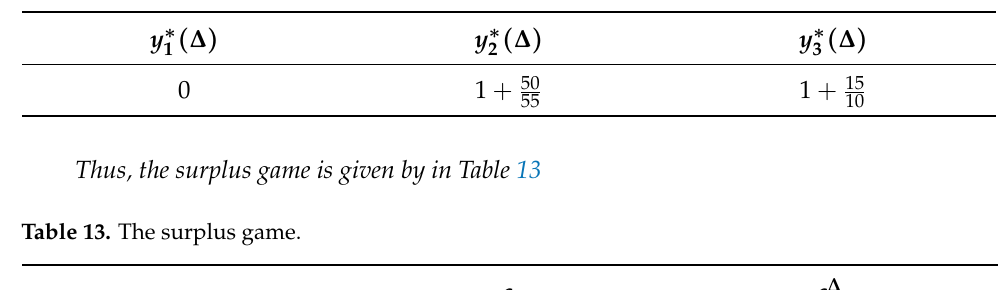
Table 12. Minimal unit prices.